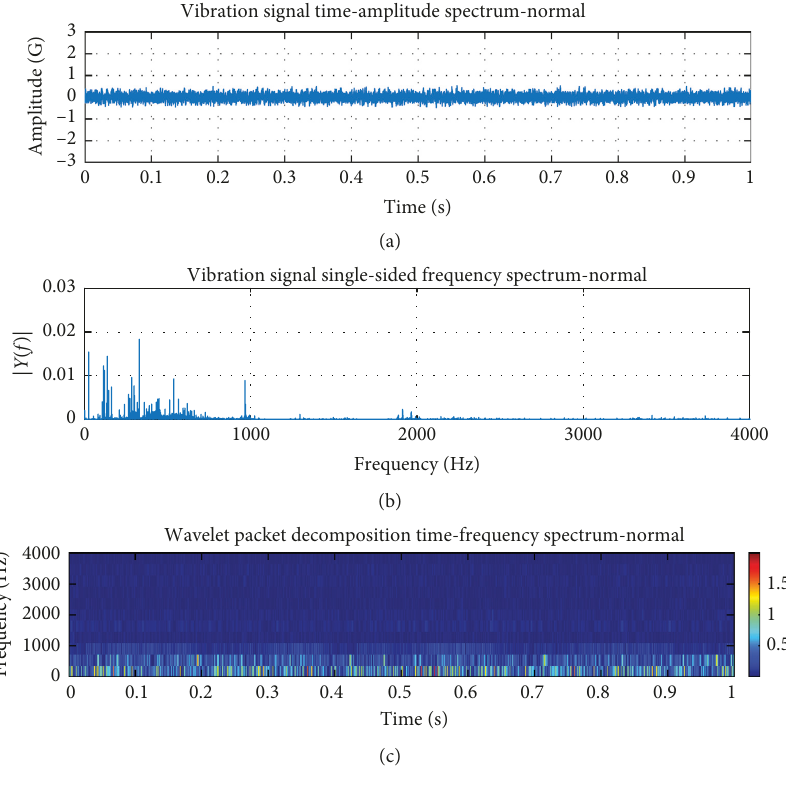
Figure 10: Vibration signal of the normal condition: (a) time-domain response; (b) FFT; (c) WPD.